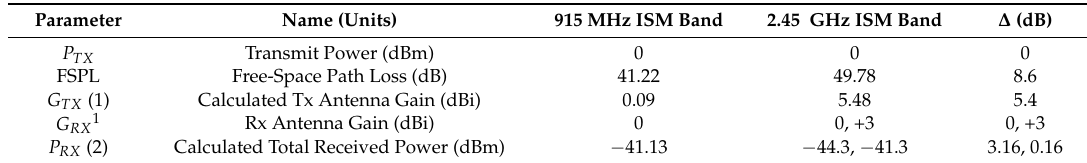
Table 1. Link budget comparison for 915 MHz and 2.45 GHz ISM